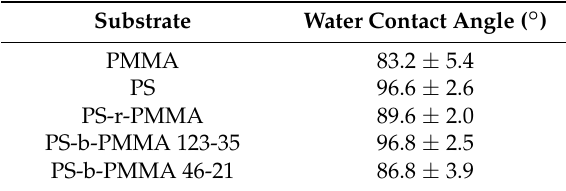
Table 2. Water contact angle measurements for different substrates. Values are reported as the mean ± standard deviation from at least 5 independent measurements.